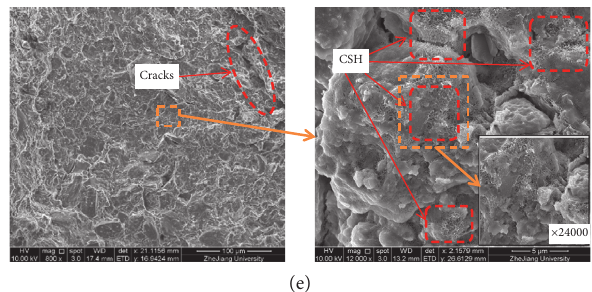
Figure 8: SEM images of MK2 group with different curing times. (a) 1d, (b) 3d, (c) 7 d, (d) 14 d, and (e) 28